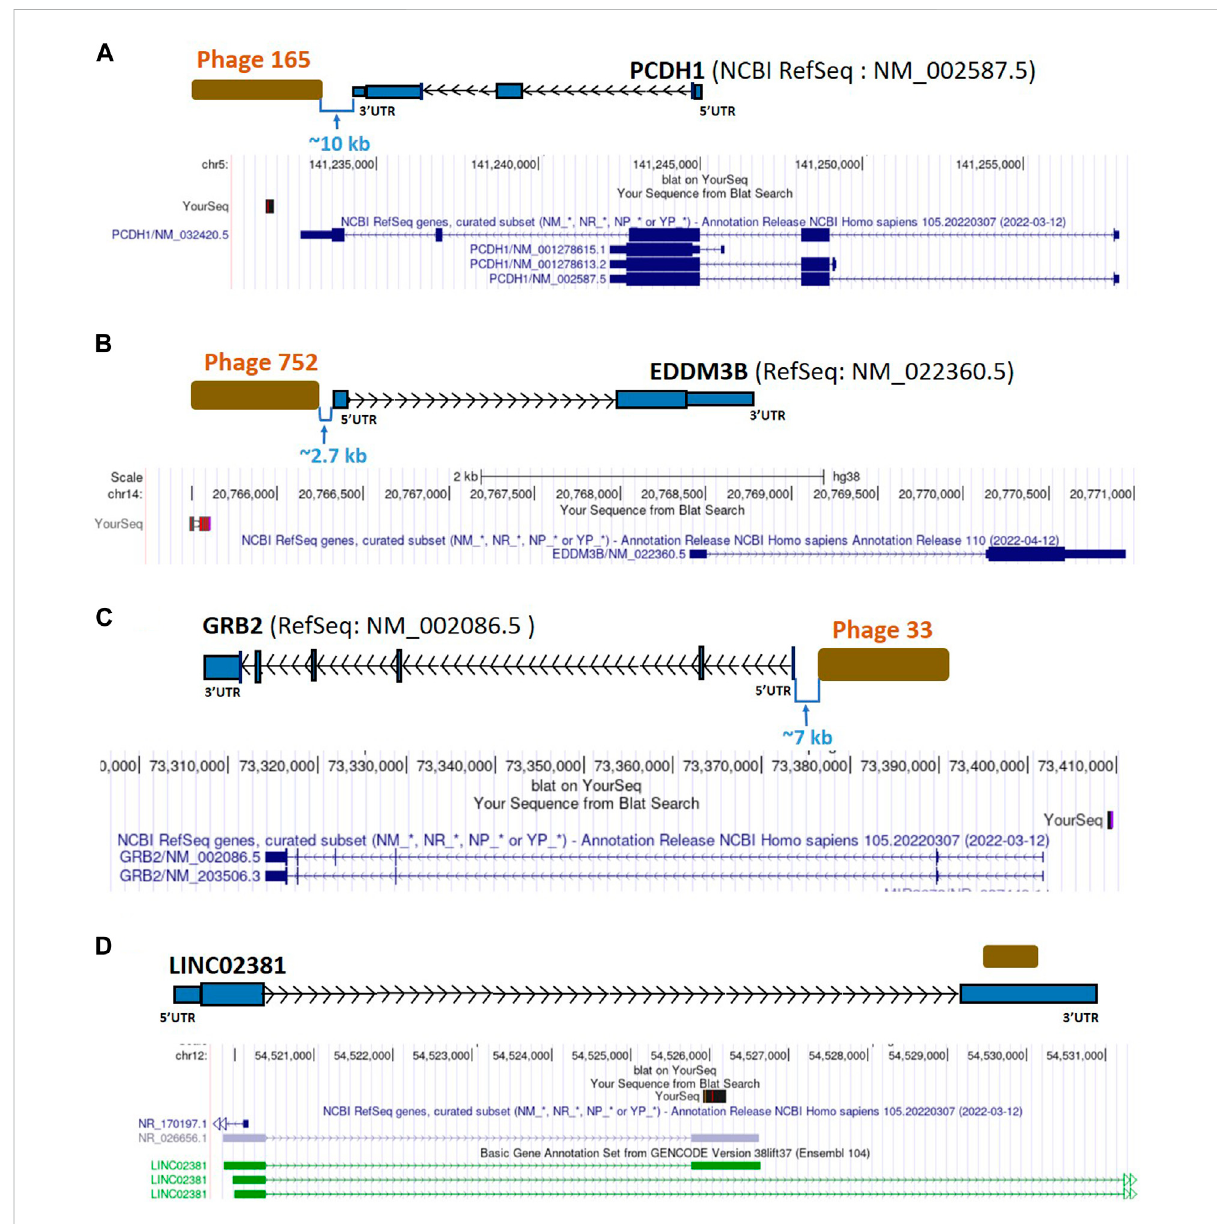
FIGURE 7 Diagrammatic representation of lncRNA LINC02381 matching and intergenic sequences from uniquely BC-patient-sera-reactive phages mapping close to PCDH1 , EDDM3B , and GRB2 . (A) Phage 165, an intergenic phage, close to the PCDH1 coding gene. (B) Phage 752, an intergenic phage, close to the EDDM3B coding gene. (C) Phage 33, an intergenic phage, close to the GRB2 coding gene and Y-RNA gene. (D) A hit within the lncRNA LINC02381 ; PCDH1 , Protocadherin 1; EDDM3B , Epididymal Protein 3B; GRB2 , Growth Factor Receptor Bound Protein 2; UTR, untranslated region; kb,